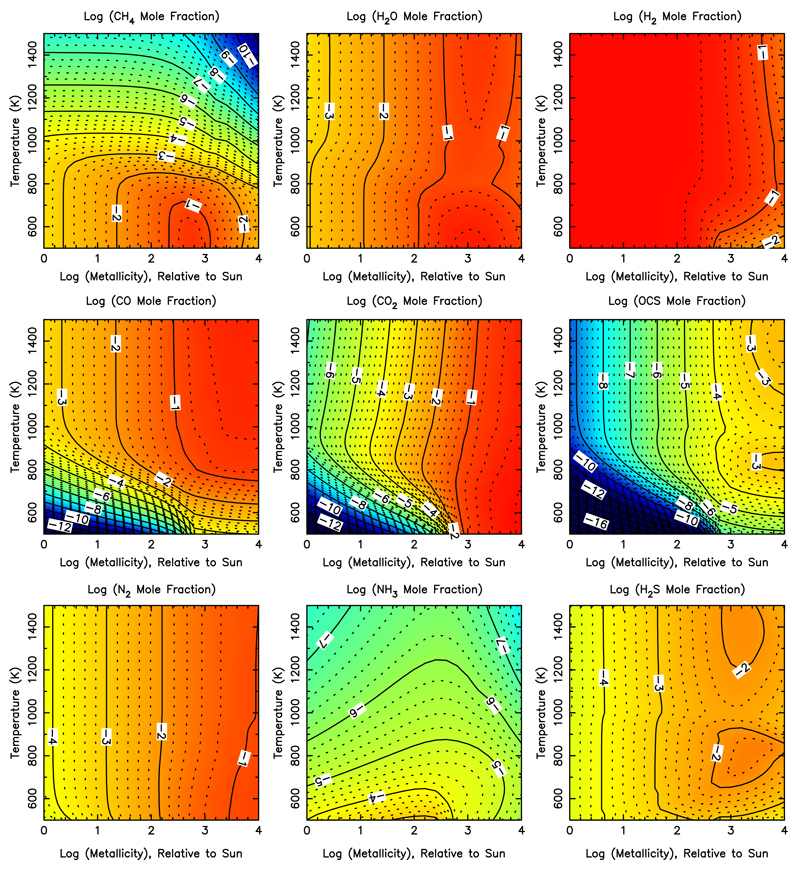
Equilibrium mixing ratios for various atmospheric constituents as a function of temperature and metallicity for an assumed typical photospheric pressure of 0.1 bar. Figure adapted from Moses et al. (2013a)